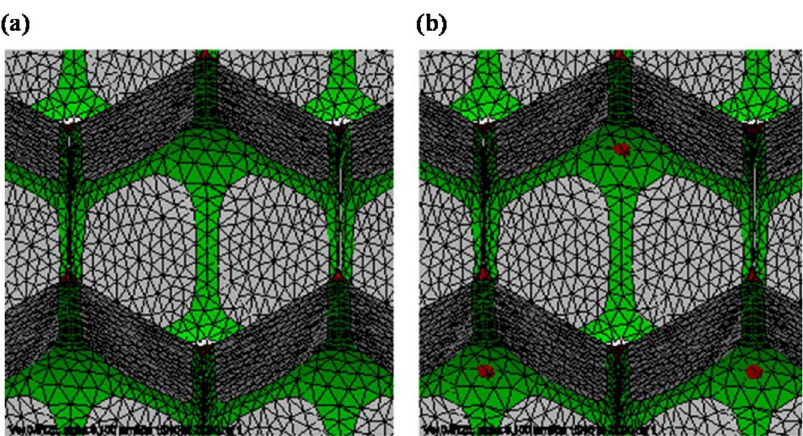
Figure 9. Overlap of cells in the transition from honeycomb to Tóth structure: ( a ) The cells just before overlap happens. ( b ) The cells just after overlap. The liquid side of the Plateau border surfaces is colored red. These images are from an early stage of evolution of the honeycomb structure for H = 2.0, ϕ liq = 1.20%, α = 0.1, and λ =